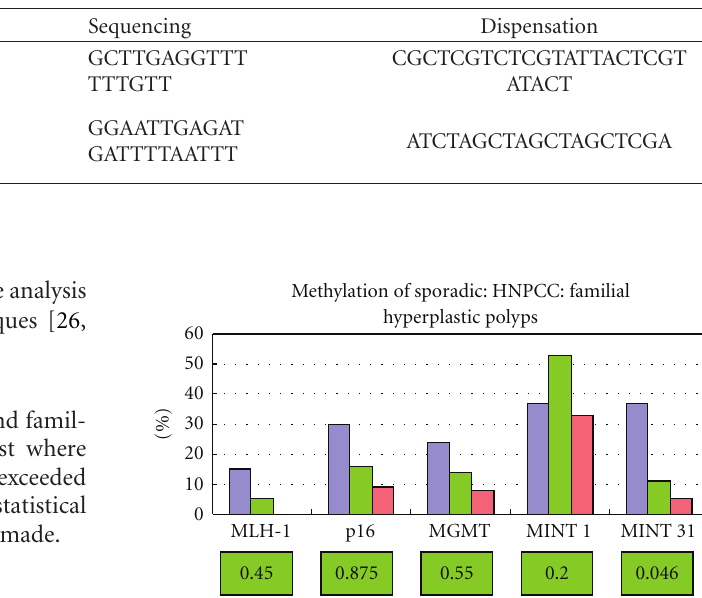
Table 5: Pyrosequencing primers for MINT 1 and 31.